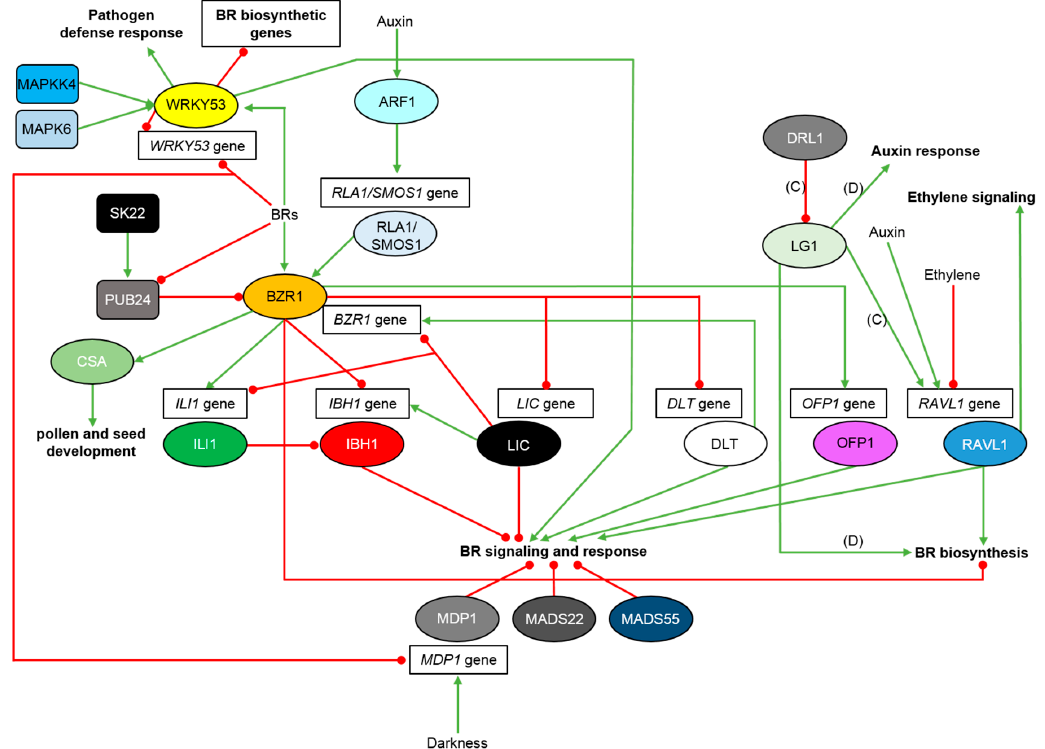
Figure 2. Molecular mechanisms of regulation of the BR-dependent gene expression in rice and other monocots. Transcription factors are shown as ovals, other proteins are depicted as rectangles. Green arrows indicate stimulation, whereas red lines with the bullet points represent suppression. Detailed description is given in the text. Some of the interactions and responses were described in maize ( C ) and wheat ( D ).